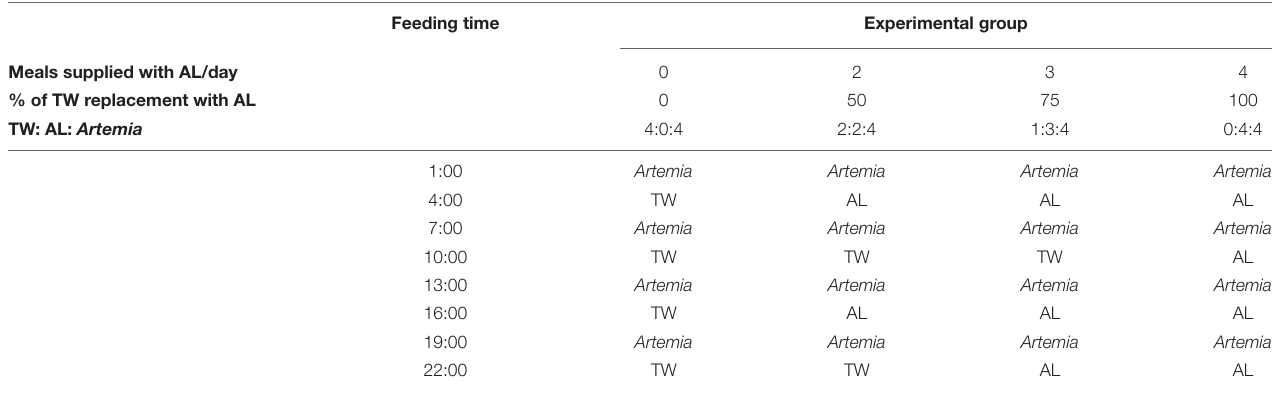
TABLE 1 | Feeding scheme of the experimental group during Mysis1 to PL2.